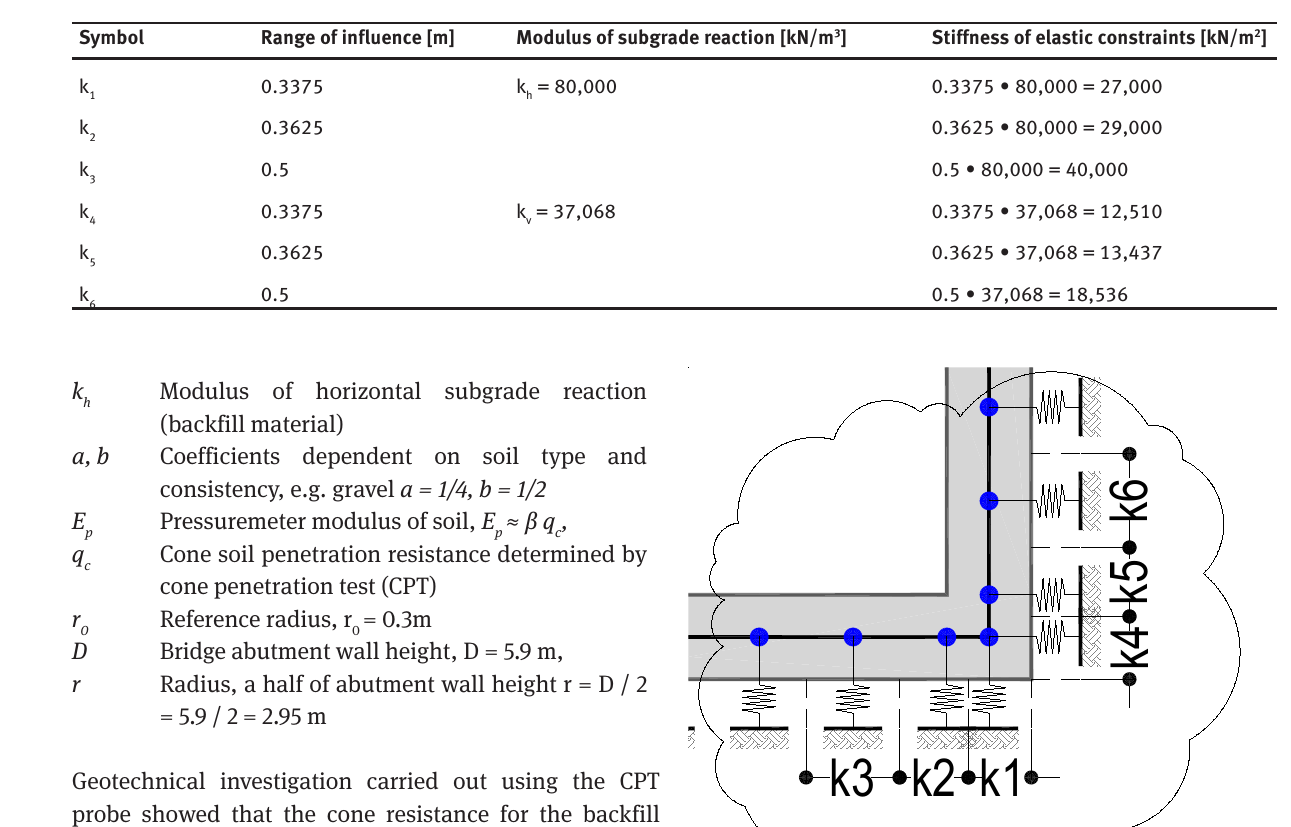
Table 6. Stiffness of elastic constraints for M-5 model.